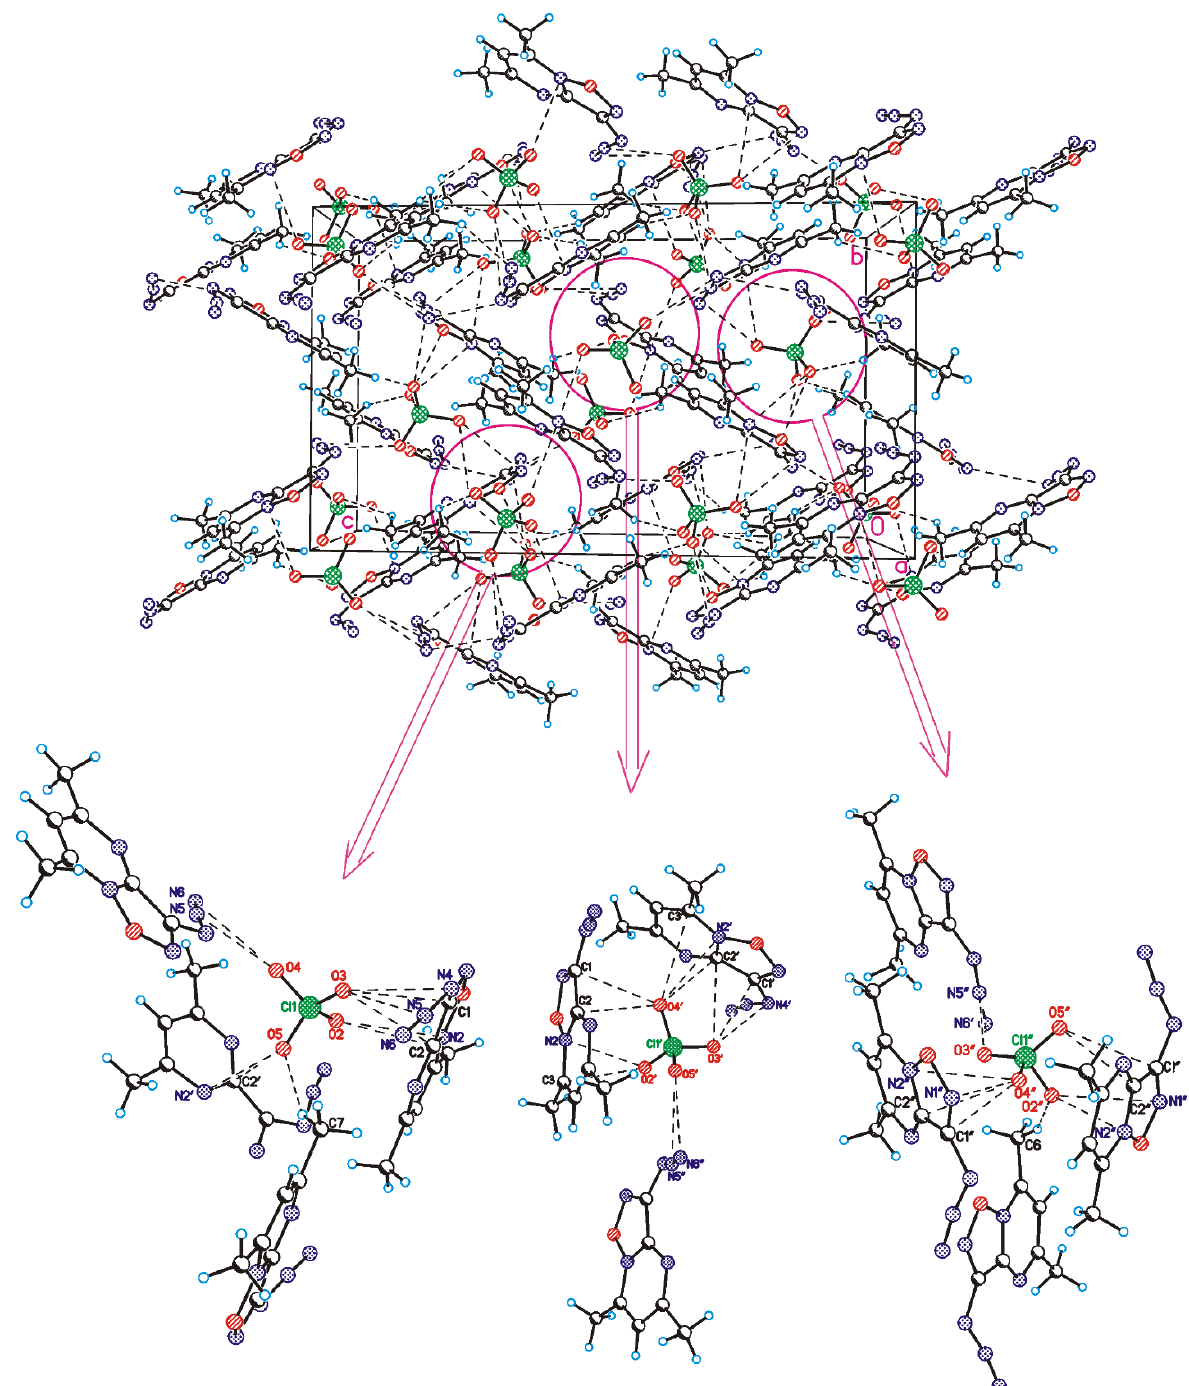
Figure 6. Crystal packing fragment of compound 10g . C – H … N cation – cation and C – H … O and O … π anion … cation interactions are shown by dashed lines. Detailed view of anion … cation interactions is provided at the bottom. Minor part of the disorder is omitted for clarity.